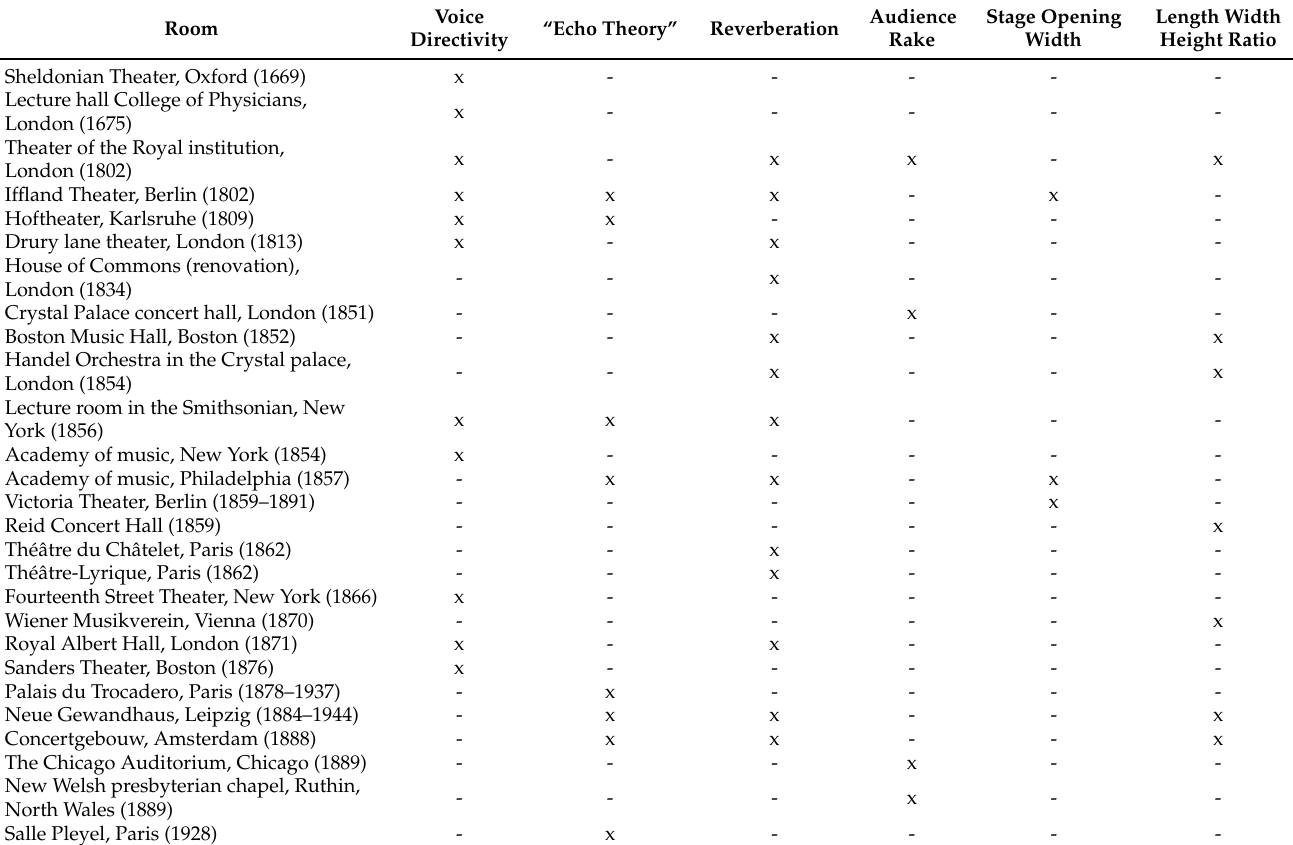
Table 2. Rooms in this and previous studies [7–9,11] and the historic room acoustical theory employed in their design and or